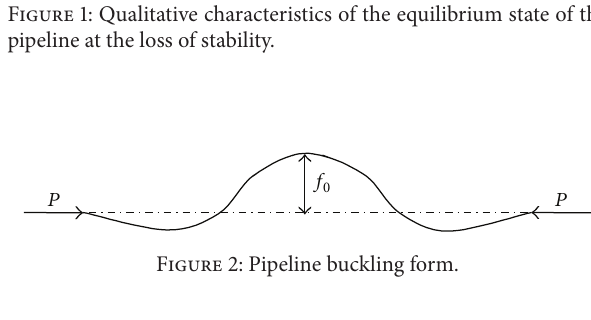
P Figure 2: Pipeline buckling